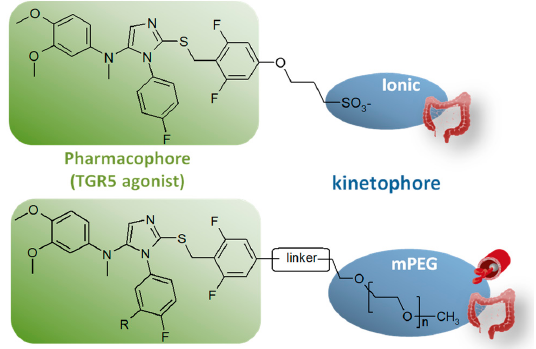
Figure 6. Chimeric TGR5 agonists with fine-tuned pharmacokinetic behavior. For the ionic kineto- phores ( top ), compounds with gut-restricted exposure were obtained. In the case of mPEG kineto- phores ( bottom ), depending on the length of the PEG moiety tethered on the pharmacophore, either systemic or gut-restricted compounds were obtained.